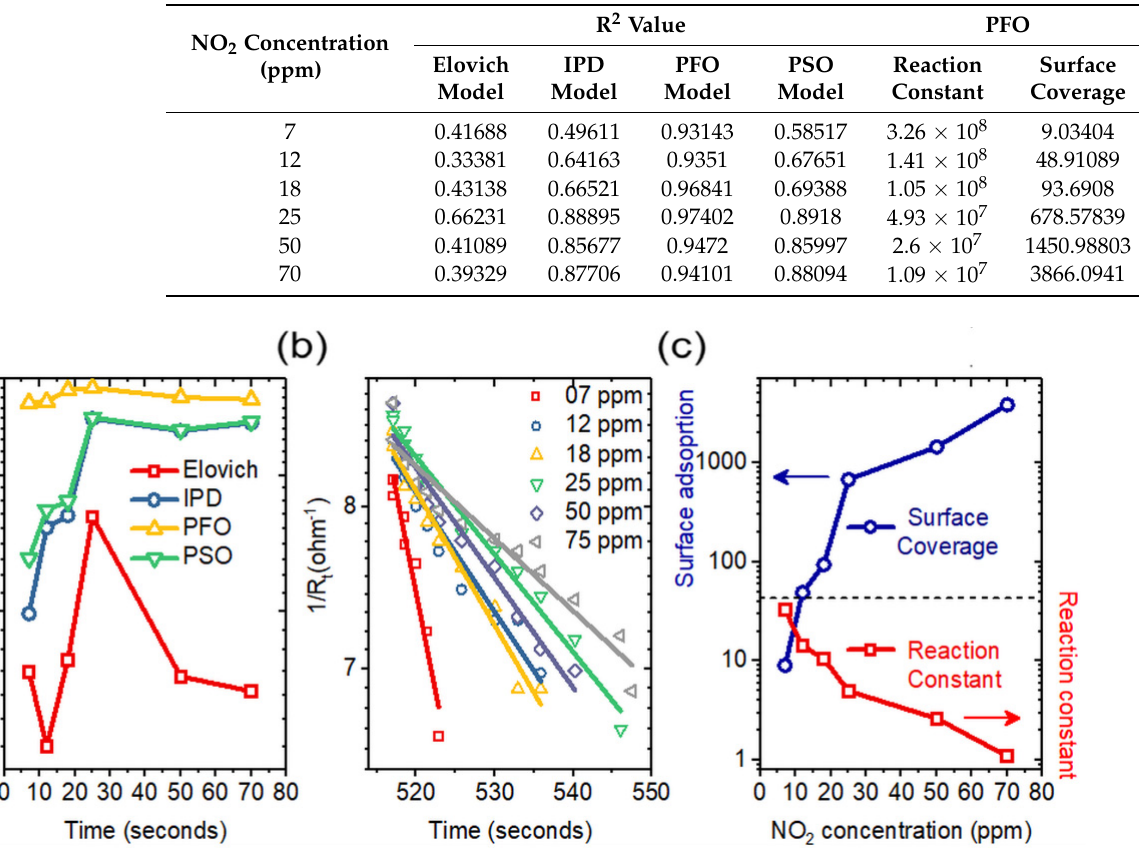
Figure 9. The comparative plot showing the R 2 values for the Elovich, IPD, PFO, and PSO models ( a ), the plot showing the linear fitting of the data by using a pseudo first-order model also known as Lagergren’s first-order model ( b ), and the estimated values of its reaction rate constant k (the squared symbols in red color), the values are normalized to 10 7 to make the plot clear to the reader, and the adsorption capacity θ e (circled symbol in blue color) values are shown in ( c ).